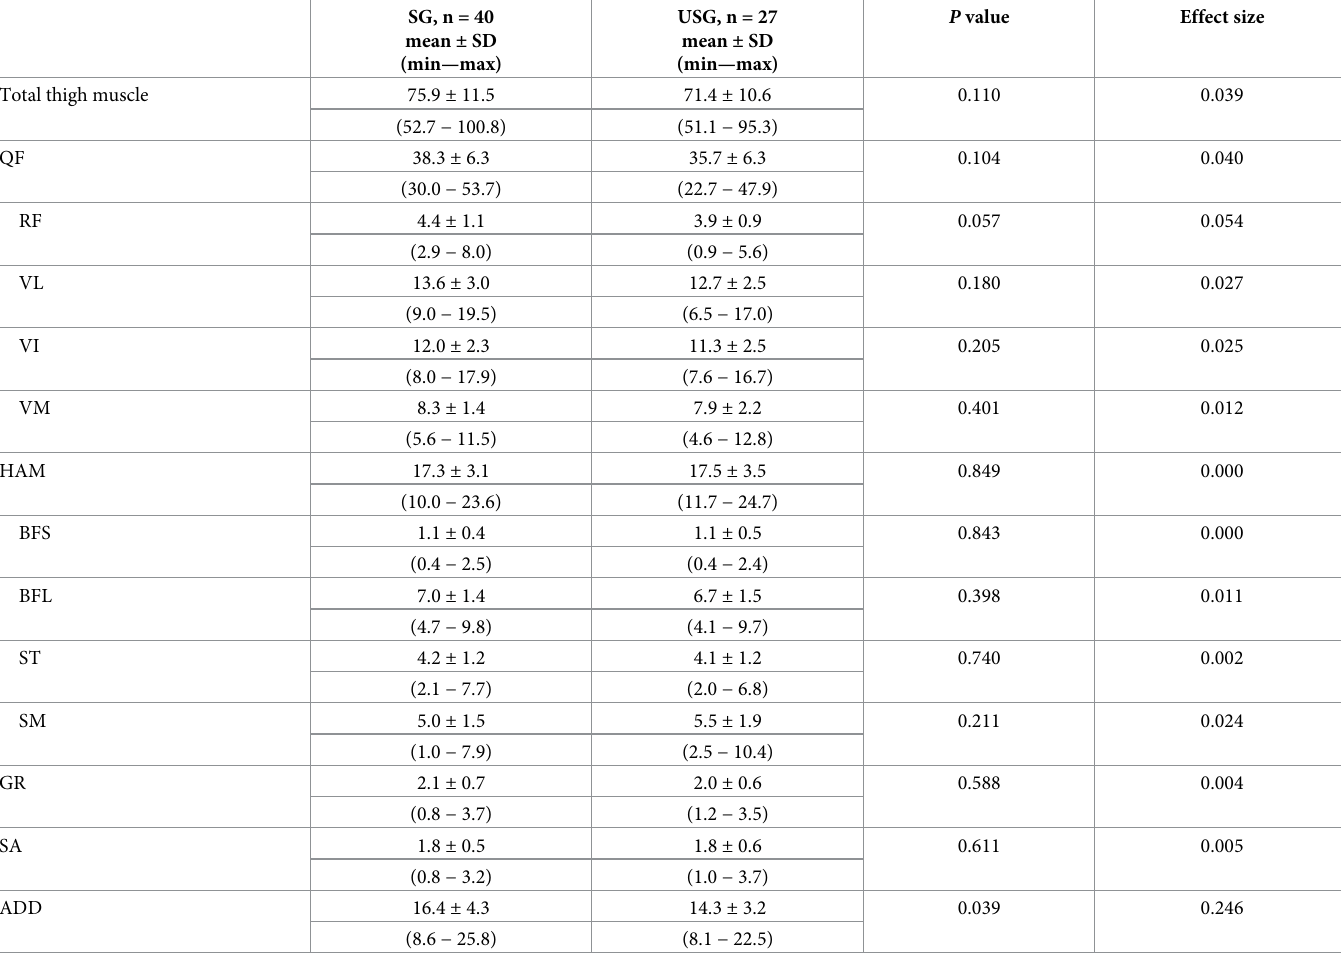
Table 2. Comparison of CSAs of individual mid-thigh muscles (cm 2 ) between SG and